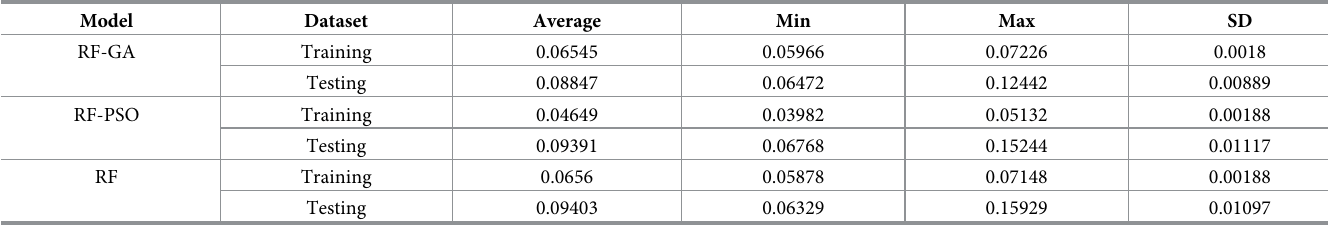
Table 6. Summary of the 1000 simulations using RMSE